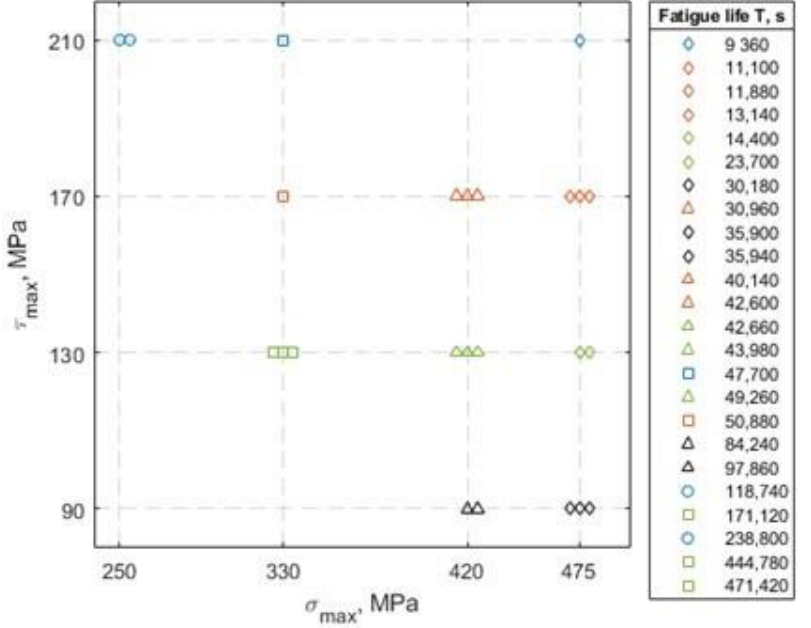
Figure 2. Pseudorandom stress histories in time: ( a ) normal stress σ ( t ); and ( b ) shear stress τ ( t ). Adopted from [33].